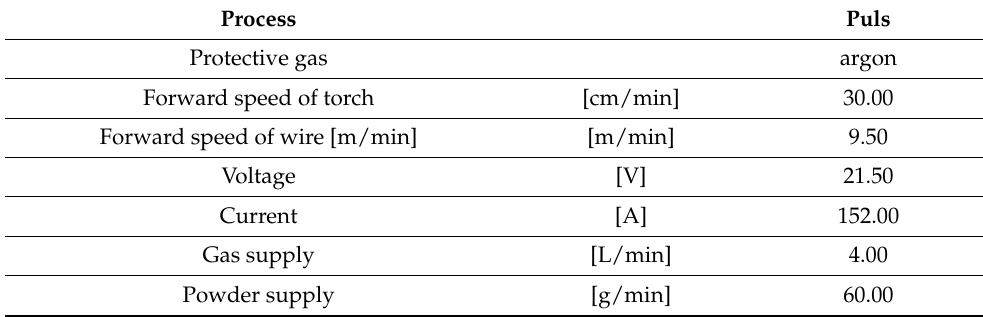
Table 4. Process influencing the variables of the GMAW